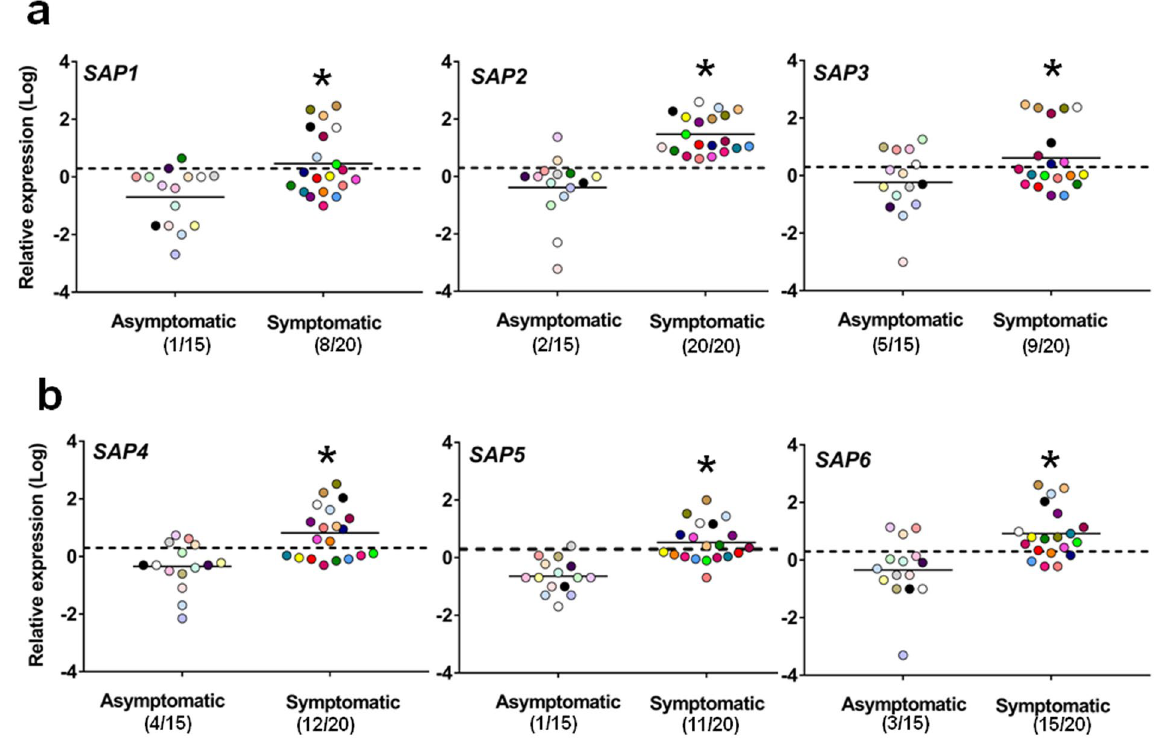
Figure 4. Quantitative analysis of SAP1-6 gene expression. Vaginal samples of asymptomatic (n = 15, identified by dots with different colors) and symptomatic (n = 20, identified by dots with different colors) women were centrifuged at 3000 rpm for 10 min, then cellular fractions were lysed and total RNA was extracted and retro-transcribed in cDNA. The expression levels of SAP1 , SAP2 , SAP3 ( a ) and SAP4 , SAP5 , SAP 6 ( b ) genes in asymptomatic and symptomatic women were calculated by comparative Ct method (2 − ∆ Ct formula) after normalization with ACT1 gene. The results are from triplicates samples of each subject and the statistical significance was determined with Mann Whitney U test. The dashed line denotes the cutoff at which the overexpression of SAP1 - 6 genes was defined as > 2 times the value of ACT1 expression and the number of women expressing genes is indicated in the brackets. * p = 0.01168 symptomatic vs asymptomatic women for SAP1 ; * p = 5.8 × 10 − 8 symptomatic vs asymptomatic women for SAP2 ; * p = 0.04212 symptomatic